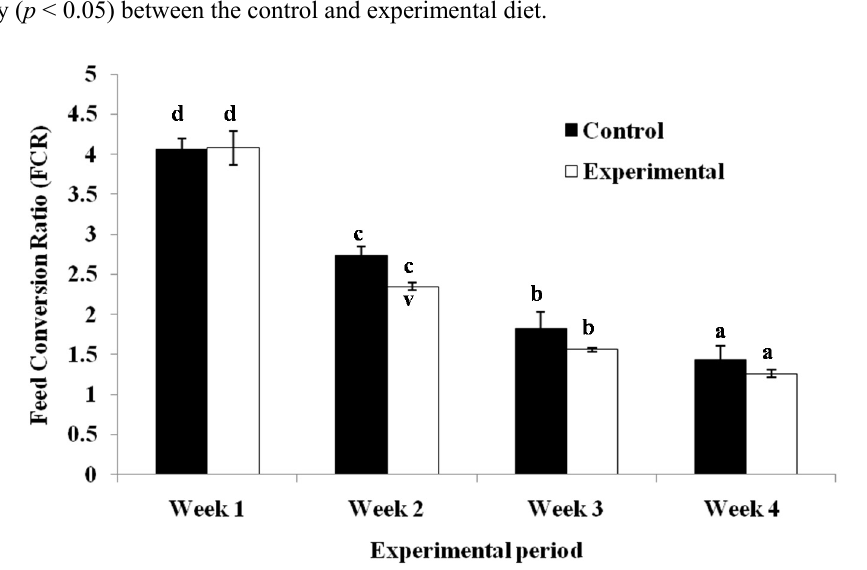
Figure 1. Effect of protein enriched diet on feed conversion ratio. All data are the mean ± SD of three replicates. Mean followed by different letters in the same column differ significantly ( p < 0.05) between the control and experimental